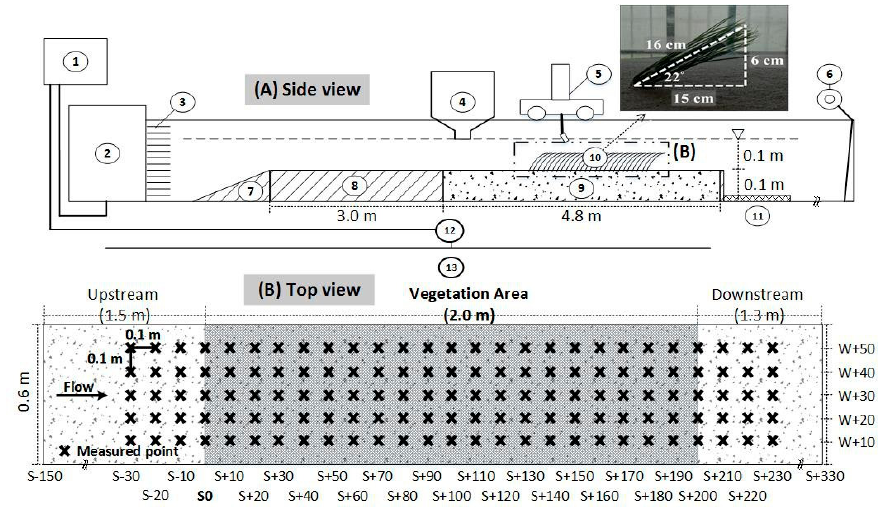
Figure 1. The flume system used for the experiments. ( A ) Side view of the flume system where: 1. Head tank. 2. Water storage tank. 3. Flow straightener. 4. Sand-supply device. 5. UVP. 6. Tail-water gate. 7. Right-angle wedge. 8. Acrylic block. 9. Quartz sand area. 10. Vegetation area. 11. Sand trap. 12. Recirculation pump. 13. Underground water tank. ( B ) Top view of the sand bed area. Vegetation models were randomly placed in the area between S0 and S+200. X symbols represent measured points.